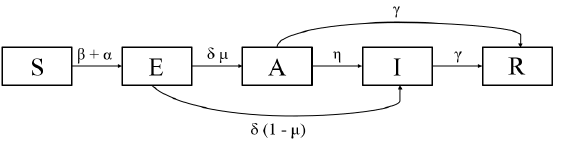
Figure 1. SEAIR model. S, E, A, I, R corresponds to susceptible, exposed, asymptomatic, infected, and recovered